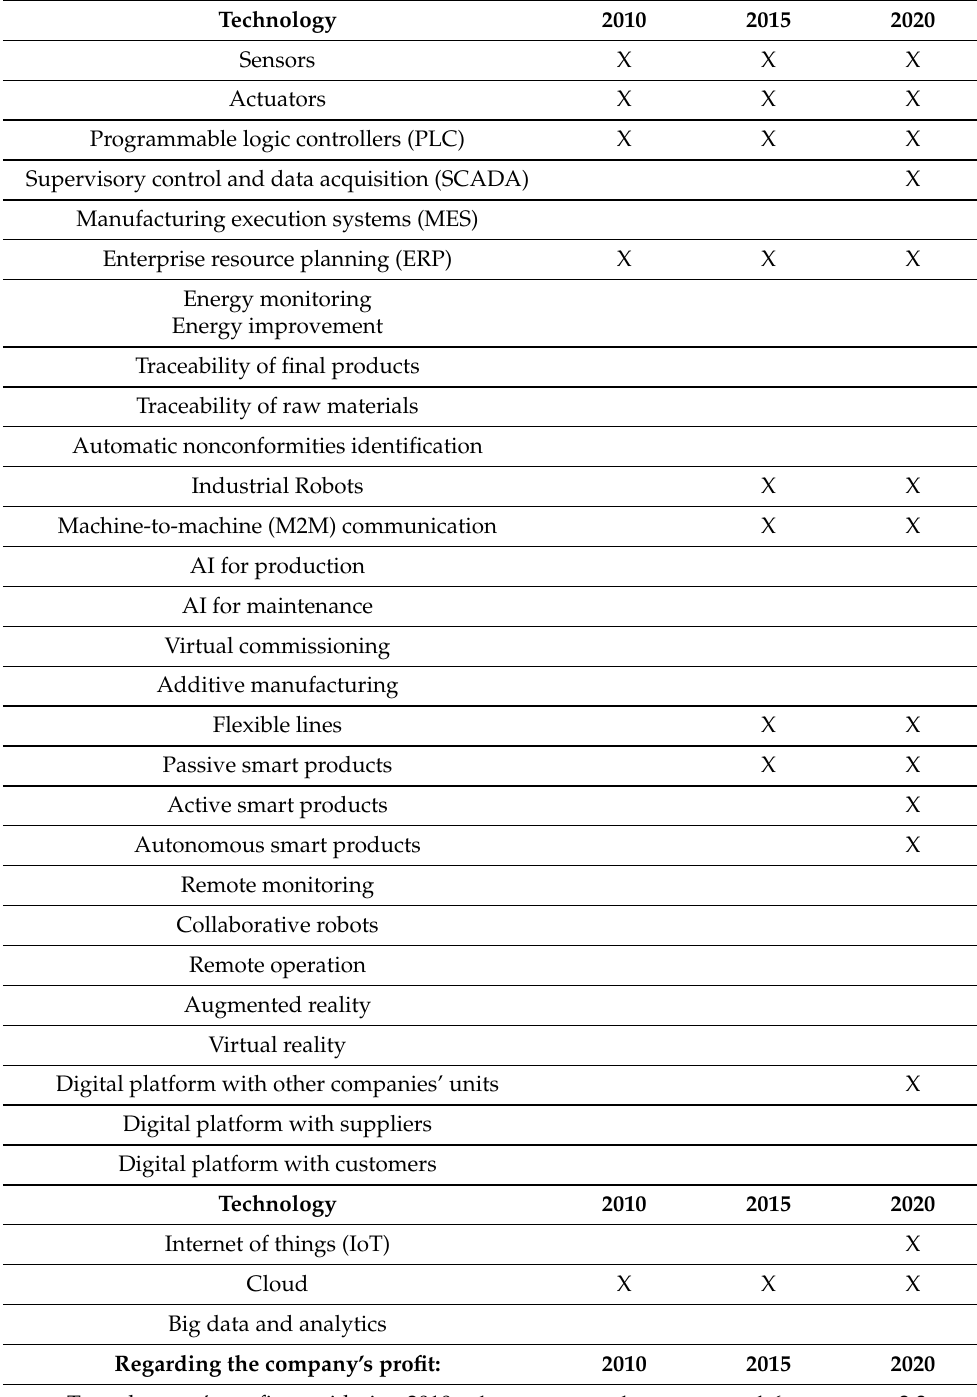
Table 6. Company A’s questionnaire results Mark the technologies used in the following